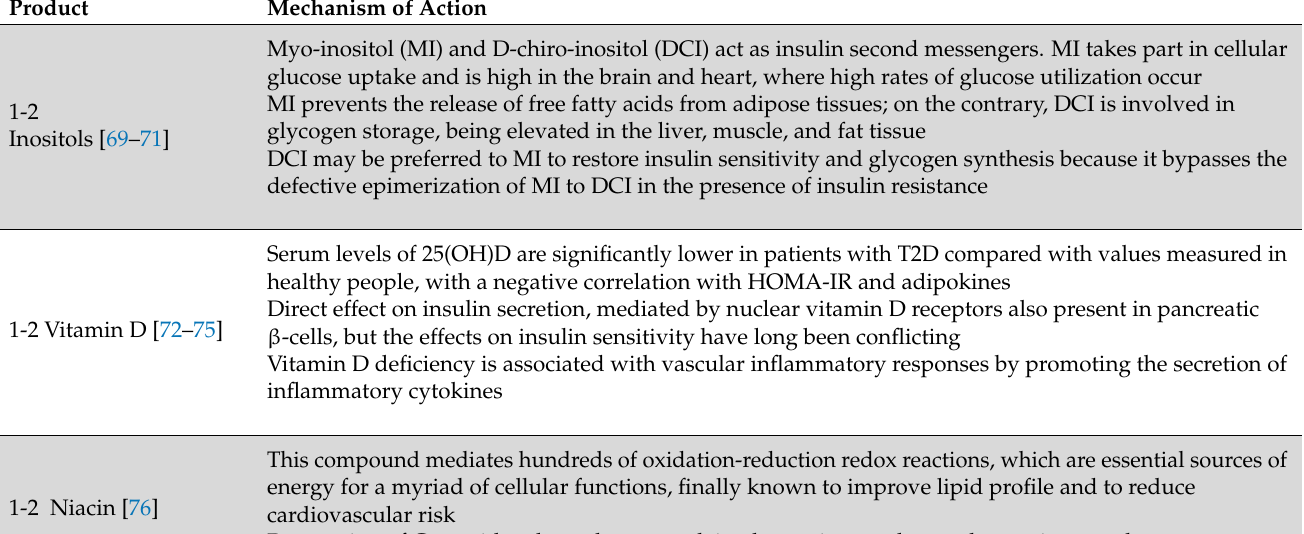
Table 3. Putative mechanism(s) responsible for the beneficial effects of nutrition supplements and micronutrients on diabetes risk and glycaemic